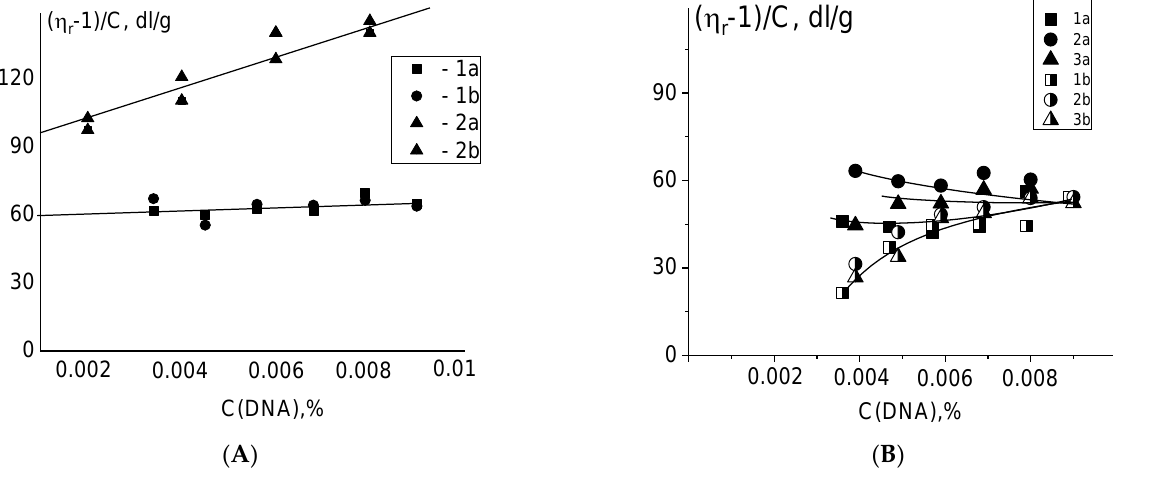
Figure 7. Dependences of the reduced viscosity of solutions on DNA concentration. Two methods of dilution of a stock solution with DNA-platinum complexes were used: at C(Pt)/C(DNA) = constant (a) and at C(Pt) = constant (b). ( A ) Results for DNA-cis-DDP adducs (1) and DNA-Pt5 adducts (2) are shown; ( B ) results for DNA adducts with Pt1 (1), Pt2 (2) and Pt3 (3) in 0.005 M NaCl are shown. C(Pt1) = C(Pt2) = C(Pt3) = 6 × 10 −5 M.